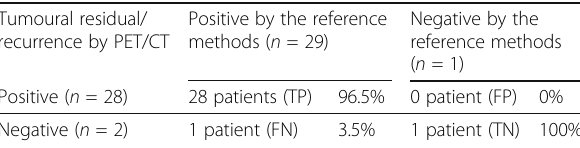
Table 4 Tumor recurrence/residual detected by 68Ga-labelled Abbreviations PET/CT: Positron emission tomography/computed tomography; 68Ga: 68 PSMA-ligand PET/CT in reference to the clinical and/or PSA level and/or radiological follow-up and/or the histopathological assessment for the patients, with the number (No.), percent (%) of the patients Tumoural residual/ Positive by the reference Negative by the recurrence by PET/CT methods ( n = 29) reference methods